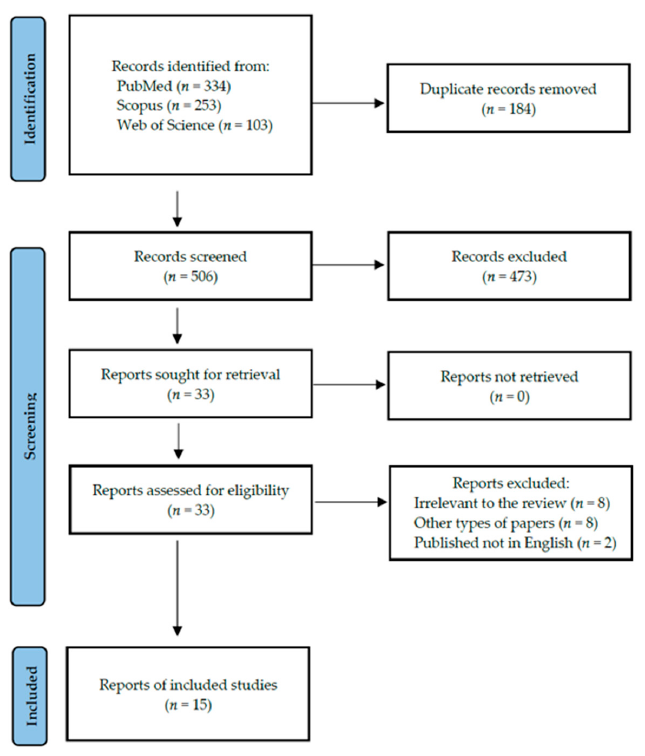
Figure 2. PRISMA flow diagram presenting the search strategy.